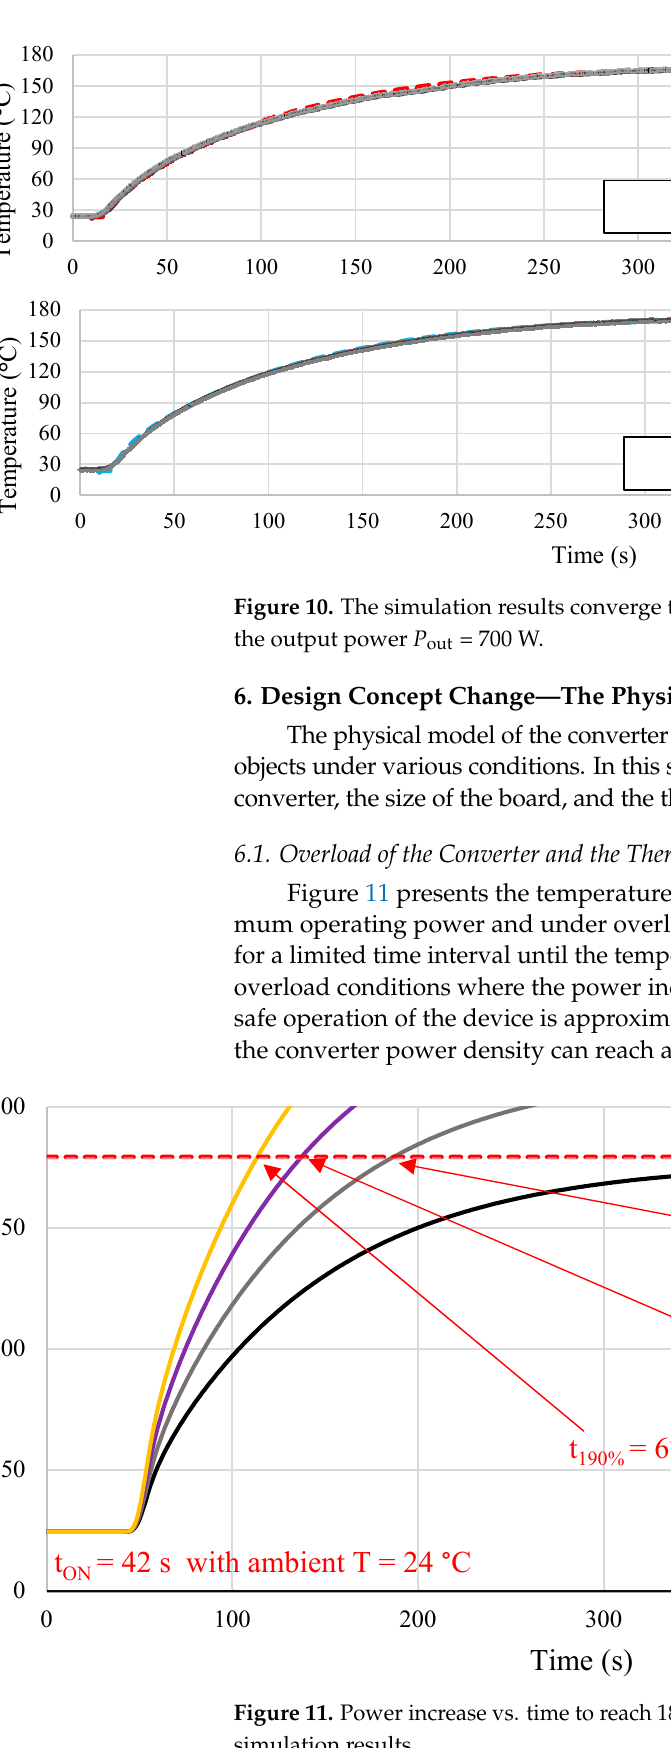
Figure 10. The simulation results converge to the experimental ones—PCB test points SP1–SP3 for the output power P out = 700 W.